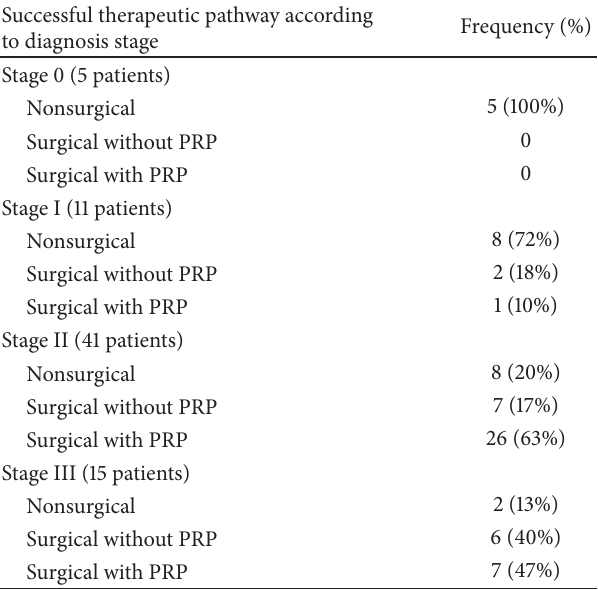
Table 4: Successful approaches according to stage at